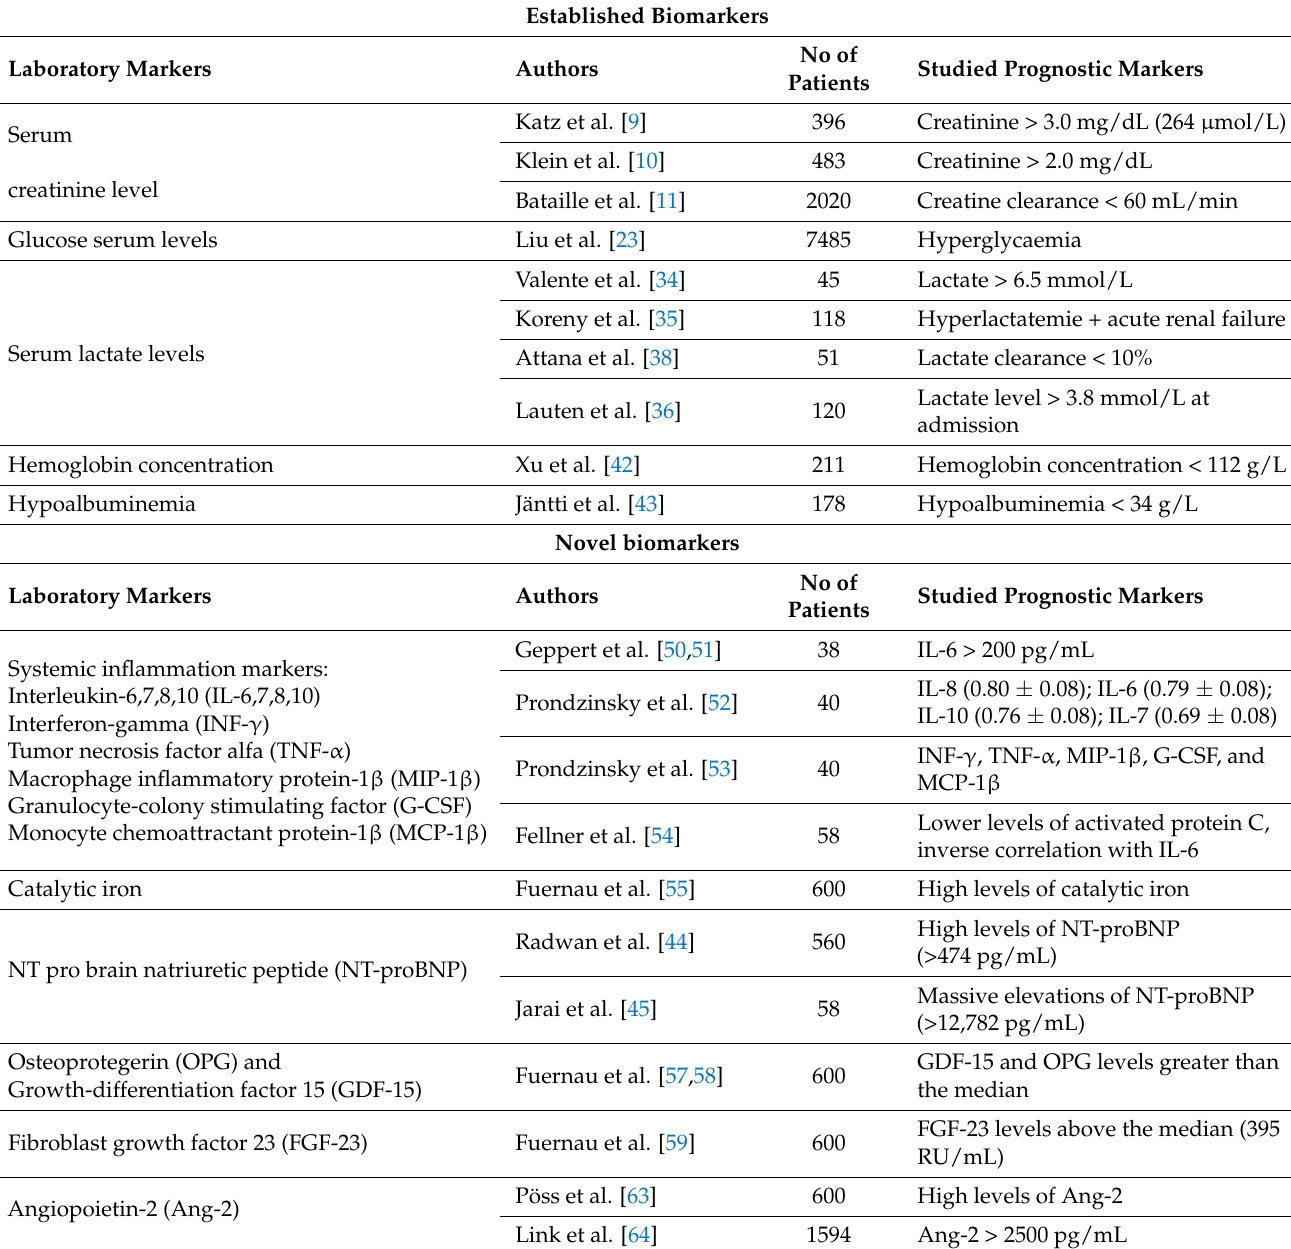
Table 4. Laboratory predictors of cardiogenic shock